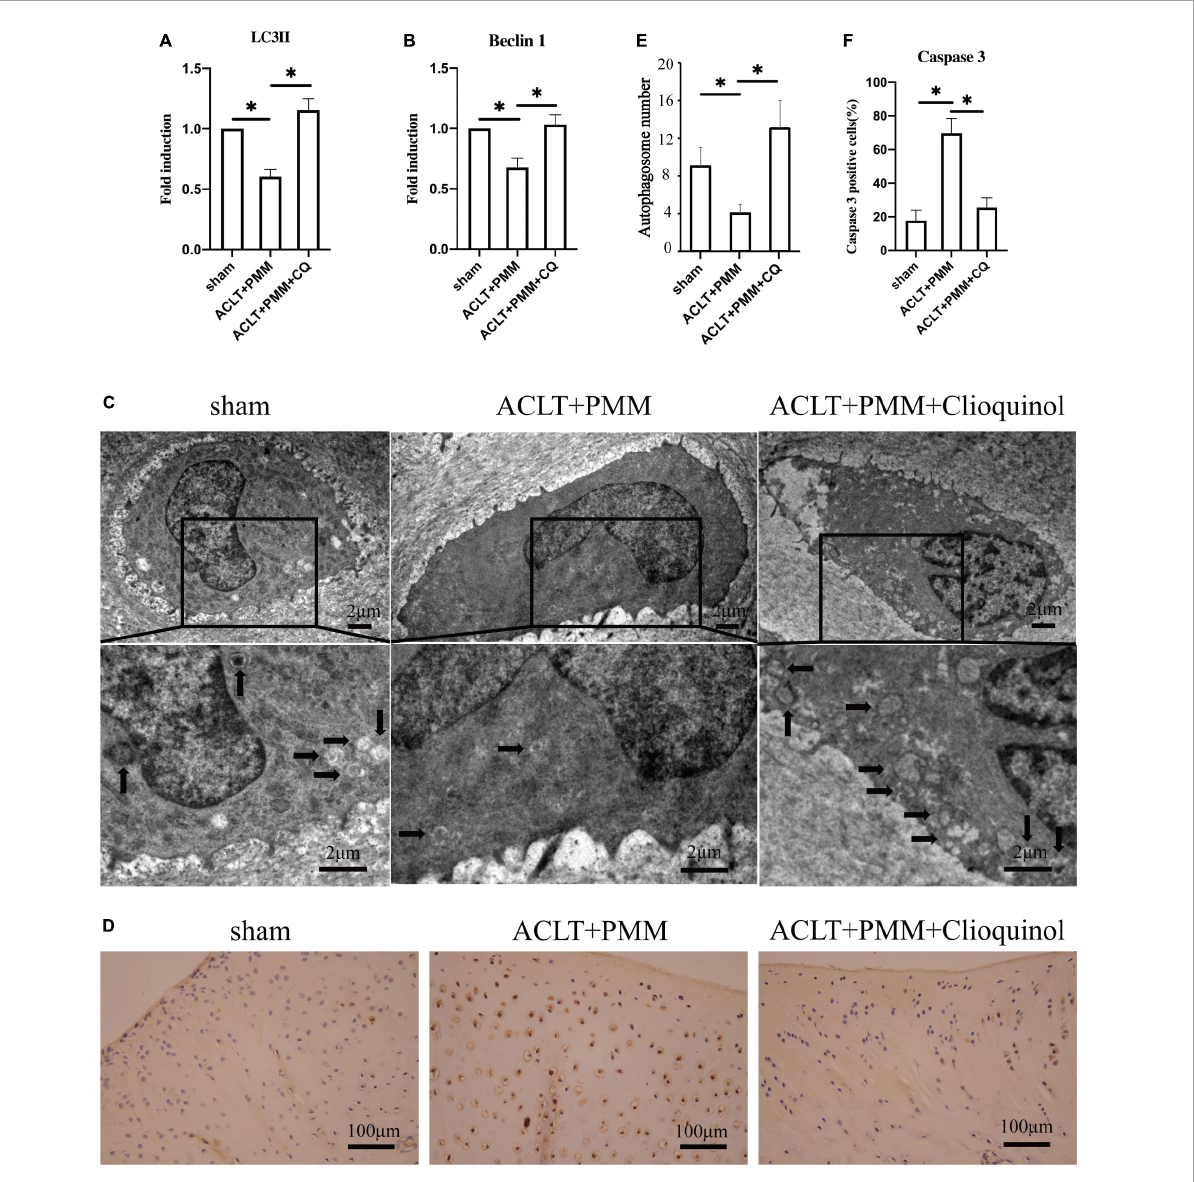
FIGURE6 (A,B) The expression of LC3 and Beclin-1 evaluated by PCR. (C,E) Autophagosome formation (arrows) detected using transmission electron microscopy. (D) Representative IHC staining showing the expression and distribution of cleaved caspase 3 in cartilage. (E,F) Quantitative analysis of autophagosome formation and cleaved caspase 3. All data are shown as the mean ± SD. ∗ p <